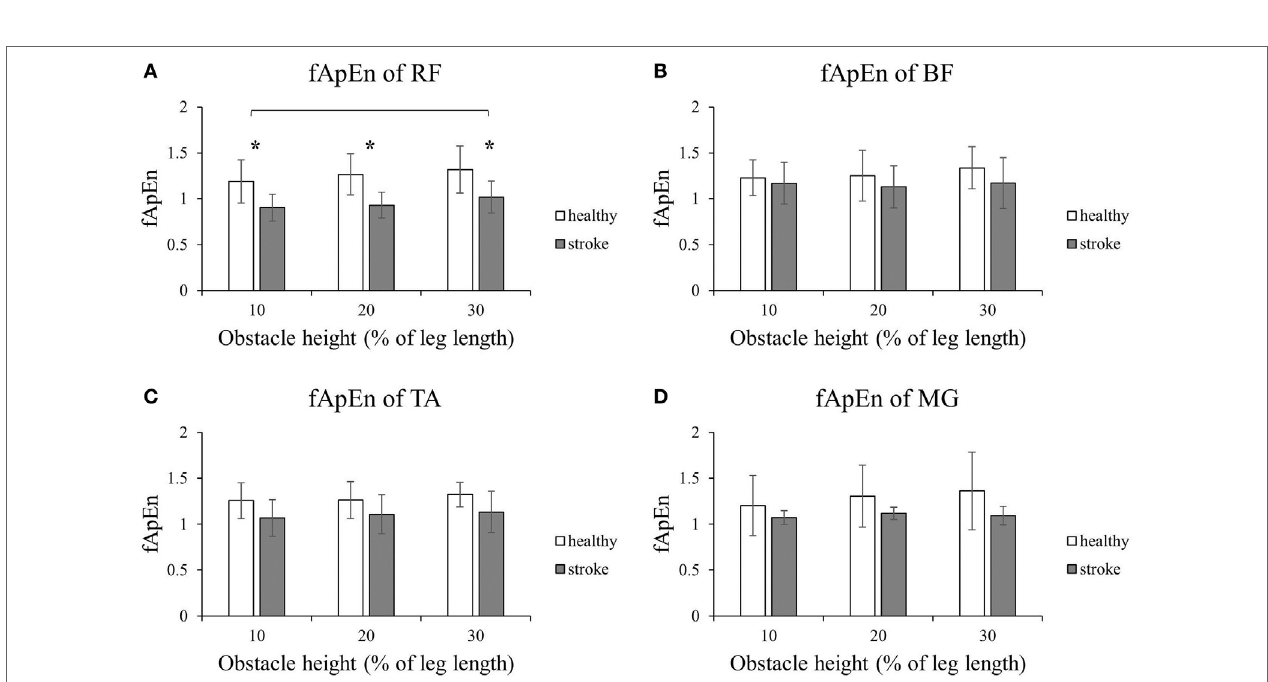
FigUre 2 | The details of fuzzy approximate entropy (fApEn) values of each height for trailing limb during stance phases. (a) The fApEn values of rectus femoris (RF); (b) the fApEn values of biceps femoris (BF). (c) The fApEn values of tibialis anterior (TA); (D) the fApEn values of medial gastrocnemius (MG).